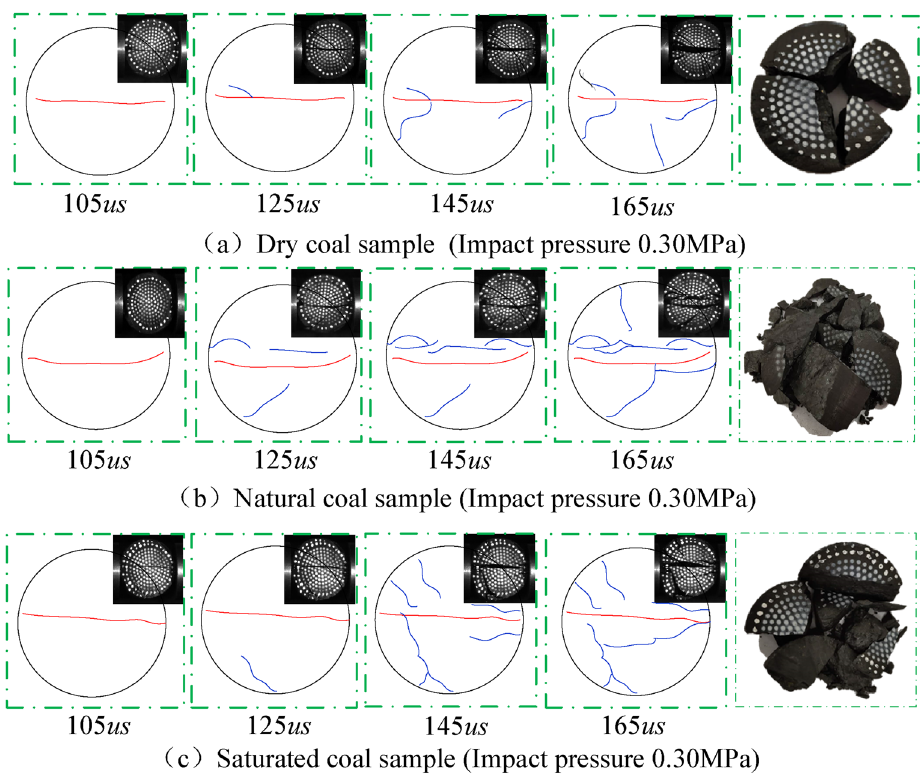
Figure 12. Sketching diagram of impact splitting failure process of coal samples with different water